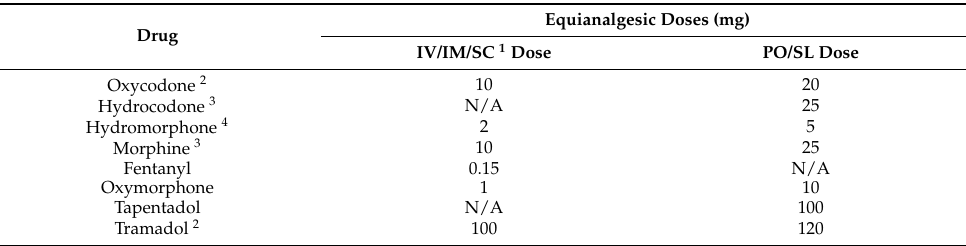
Table 1. Current Recommendations for Equianalgesic Dosing of Opioids Commonly Encountered in Perioperative